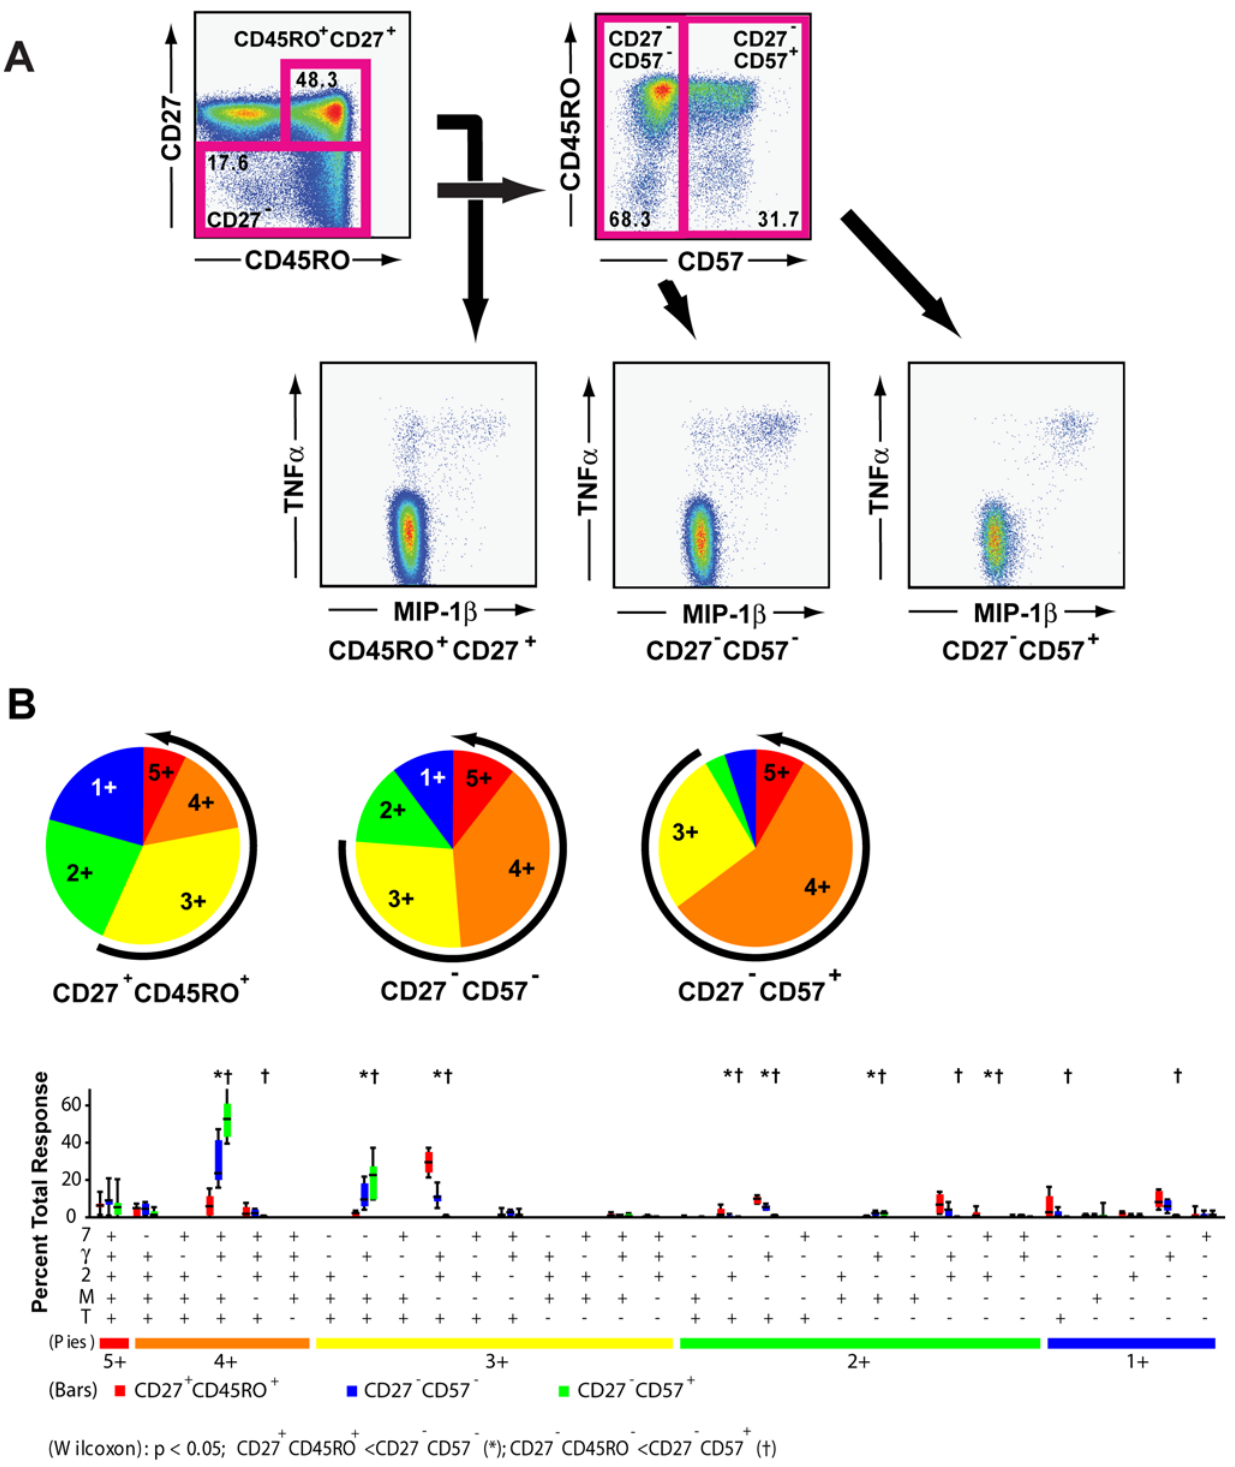
Figure 3. pp65-specific CD4 + T cells become more polyfunctional with increasing maturity. A) Representative plots showing sorting of CD4 + T cells into CD27 + CD45RO + , CD27 2 CD57 2 and CD27 + CD57 + populations and their respective staining for TNF a and MIP-1 b . The percentage of CMV-specific CD4 + T cells which produced both TNF a and MIP-1 b increased dramatically with increasing maturation. B) Maturation markedly increased polyfunctionality of pp65-specific CD4 + T cells. Percentage of the total response for CD27 + CD45RO + (red bars), CD27 2 CD57 2 (blue bars) and CD27 2 CD57 + (green bars) memory CD4 + T cells is shown for each of the 31 functional species for each specific maturational subset. Significant differences in the frequency of functional subsets is shown between CD45RO + CD27 + and CD27 2 CD57 2 memory CD4 + T cells by a * ( P , 0.05) and for differences between CD45RO + CD27 + and CD27 2 CD57 + memeory CD4 + T cells by a { ( P , 0.05).